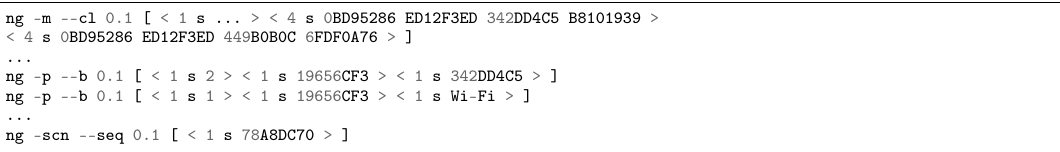
Figure 6. Example of a NovaGenesis exposition message. In the current prototype, NovaGenesis messages carry command lines with one or more arguments. The messages are textual, to facilitate development. Future versions will include source encoding to reduce overhead. In the current form, messages can be manually entered by a user.